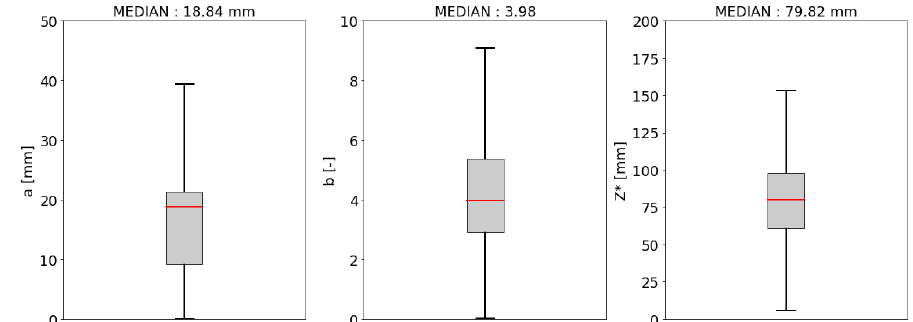
Figure A2. Boxplot showing the calibrated values of the parameters a , b , and Z ∗ over the Ebro basin.